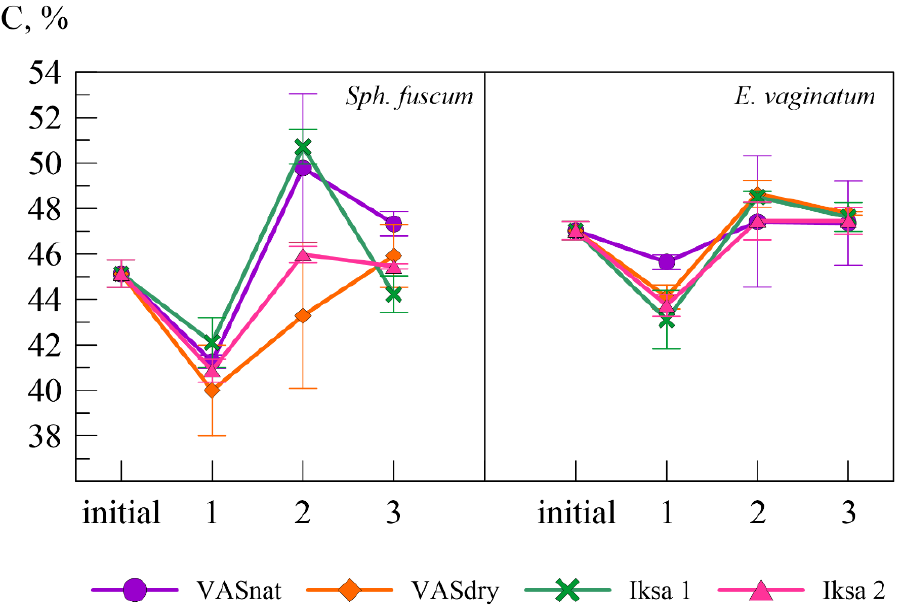
Figure 4. Dynamics of carbon content in the process of transformation of plant residues of Sph. fuscum and E. vaginatum.